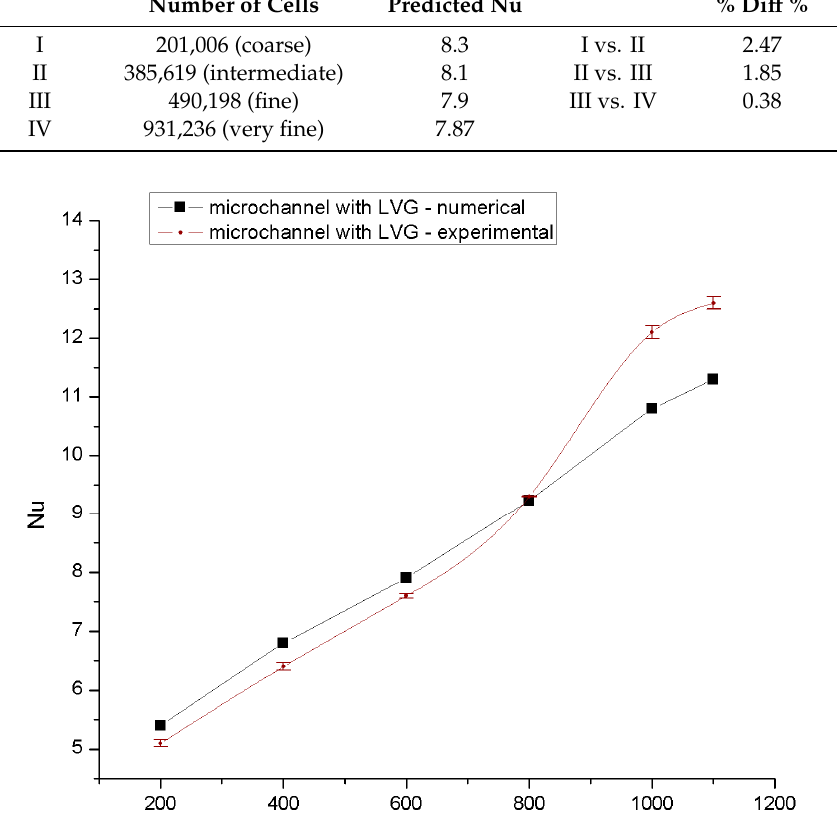
Table 3. Grid independence test results at Re = 800.